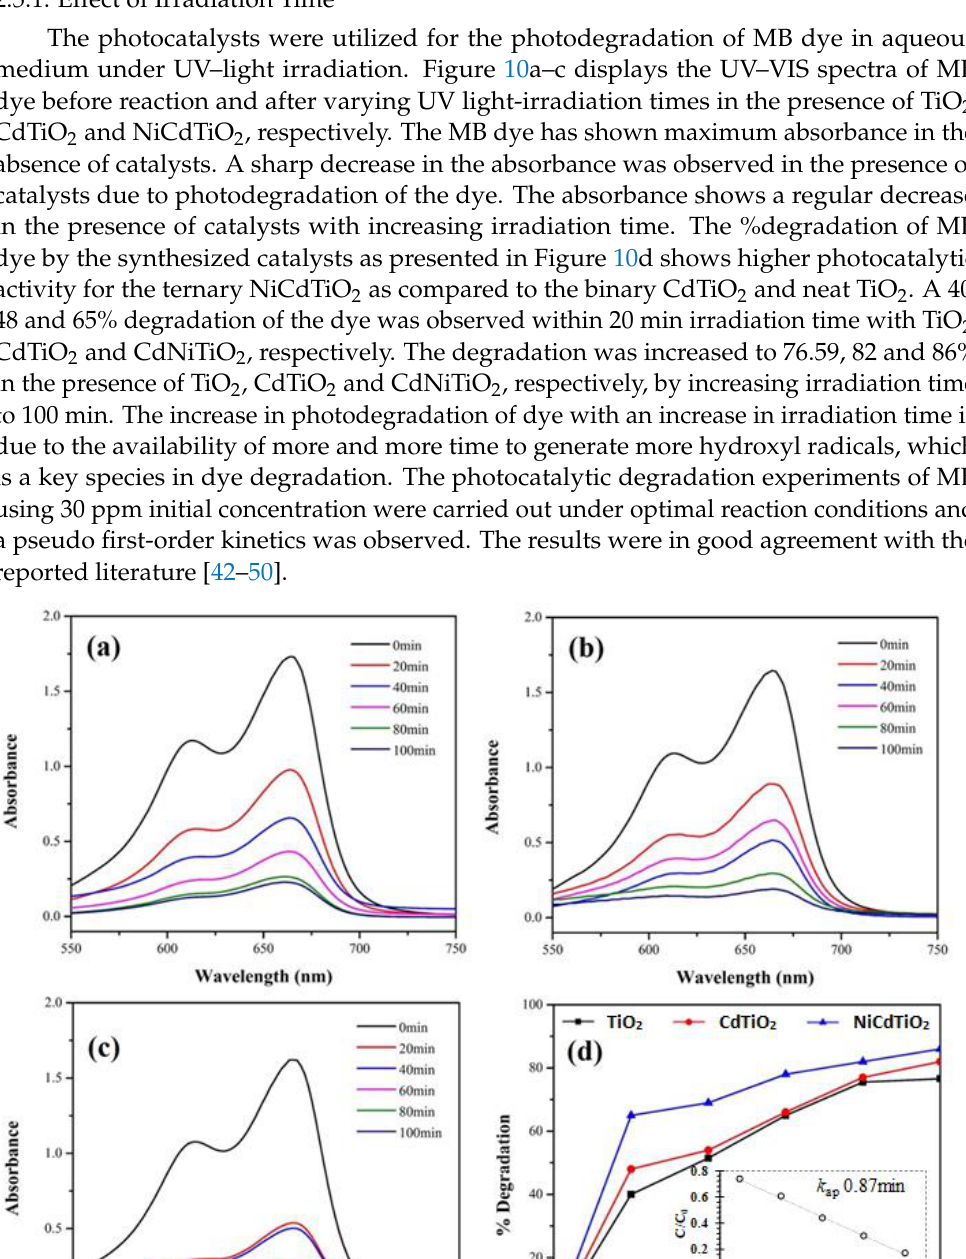
Figure 9. Tauc plots: (αһv) 2 versus energy for the ( a ) TiO 2 ( b ) CdTiO 2 ( c ) NiCdTiO 2 , inset; compari- son of band gap energy .